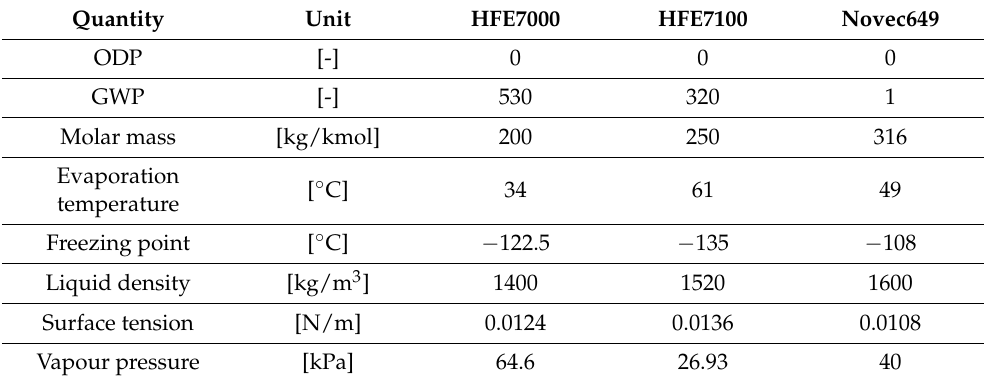
Table 3. Examples of the tested refrigerants properties at ambient pressure